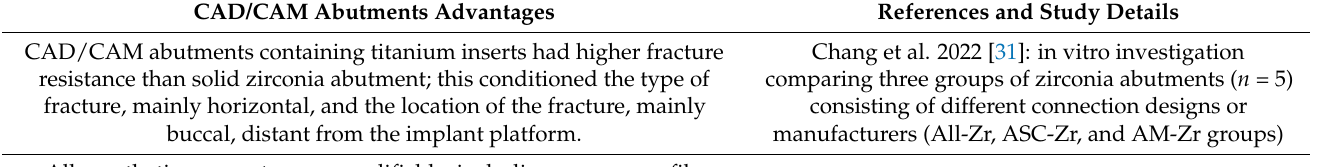
Table 2. Summary table of the advantages and equalities of CAD/CAM and stock